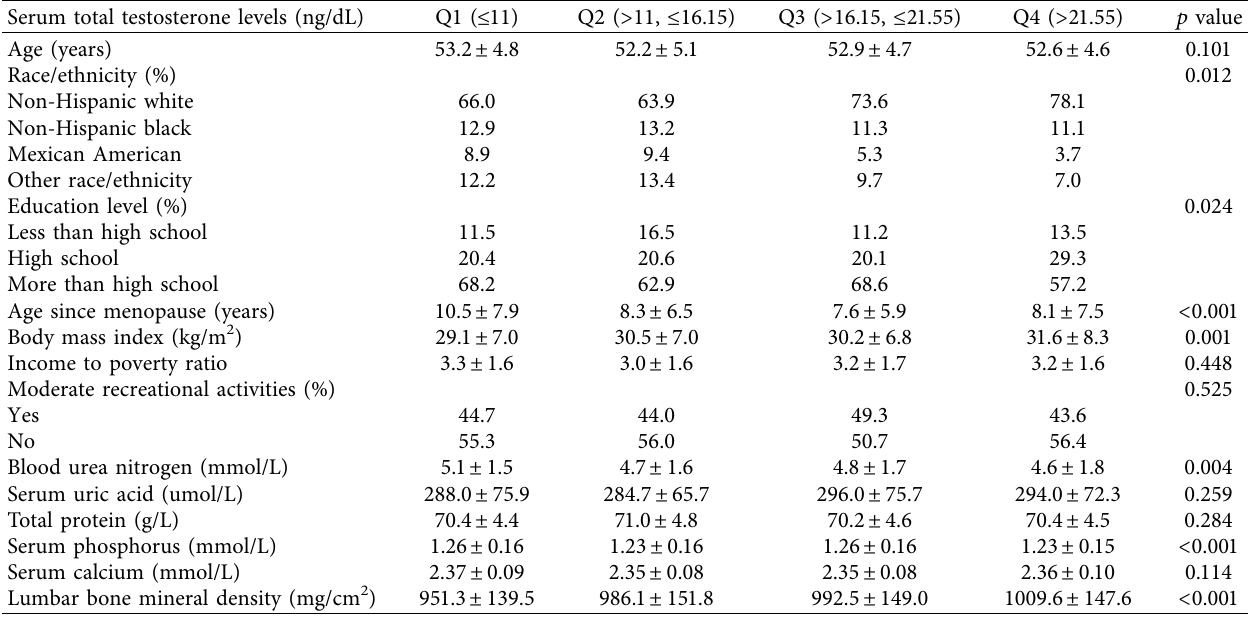
Table 1: Weighted characteristics of study population based on serum total testosterone level quartiles.